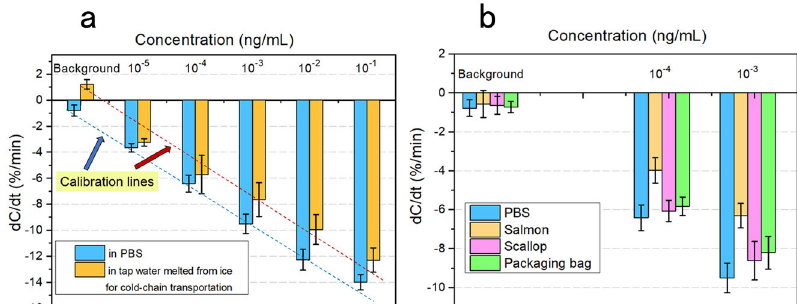
Fig. 5 S-protein detection in practical samples. a Dose response from S-protein in melted tap water from the ice for cold-chain transportation. Five concentrations from 10 − 5 to 10 − 1 ng/mL are spiked and detected in the tap water, and the calibration is performed as a red dashed line. The blue dashed line as a standard calibration in PBS is provided for comparison. b S-protein detection in three samples associated with cold-chain food. Leaching solutions are obtained from salmon, scallop, and packing bag for beef, all having two theoretical concentrations (10 − 4 and 10 − 3 ng/mL). The corresponding backgrounds are as a quality control for the sensors before application. The response in 0.1× PBS is provided as a reference. In Fig. 5, each error bar representing standard deviation is obtained using the responses from the same sample tested with three